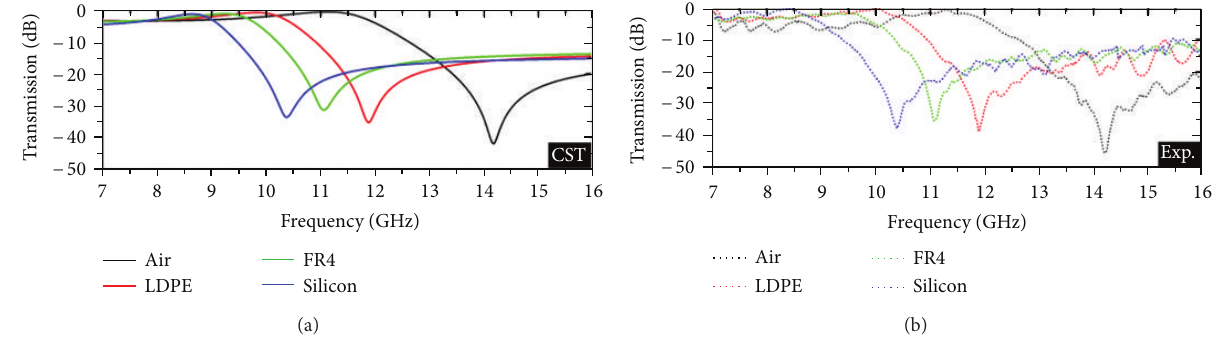
Figure 12: Simulation ((a) solid lines) and experimental results ((b) dotted lines) regarding the transmission of the slab pair structure enclos- ing several materials with a thickness of 0.5 mm [46].